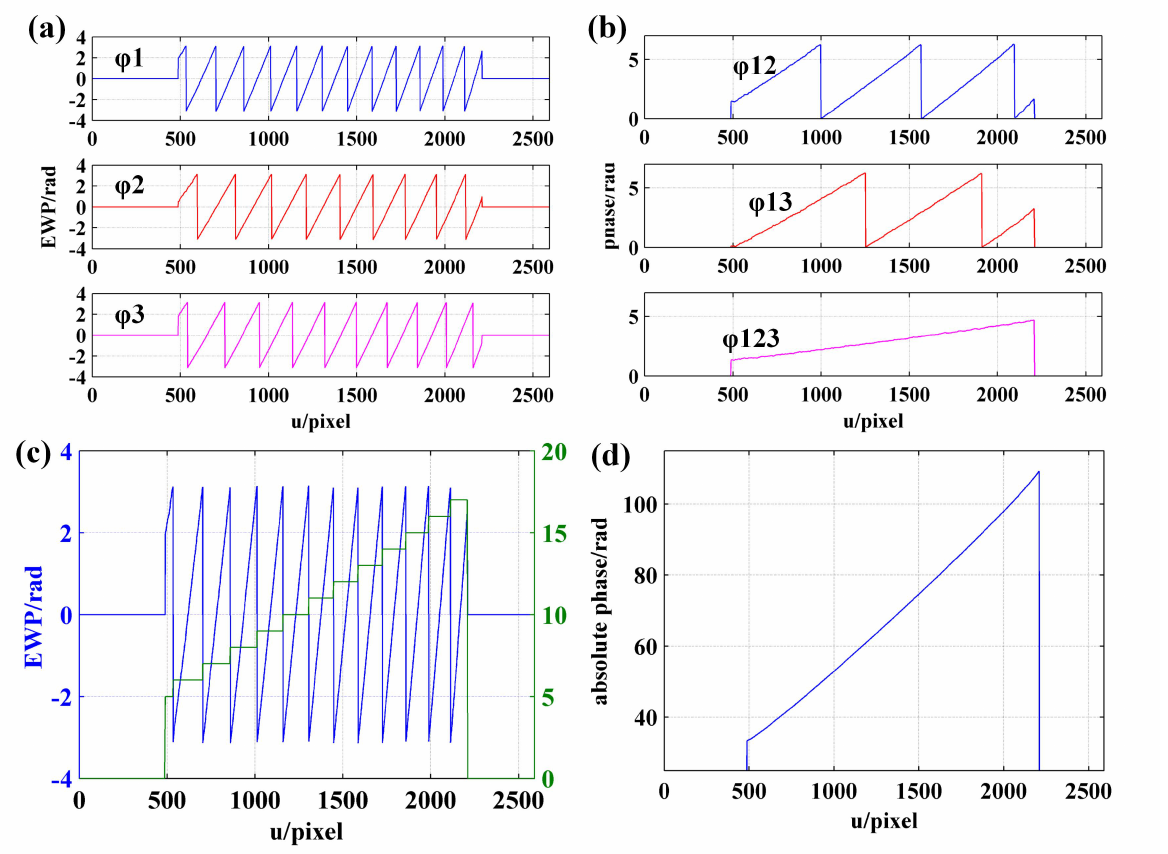
Figure 13. Phase unwrapping result of row 1000 obtained by three-frequency phase-shift method: ( a ) EWP; ( b ) equivalent phase; ( c ) EWP and fringe order; ( d ) absolute